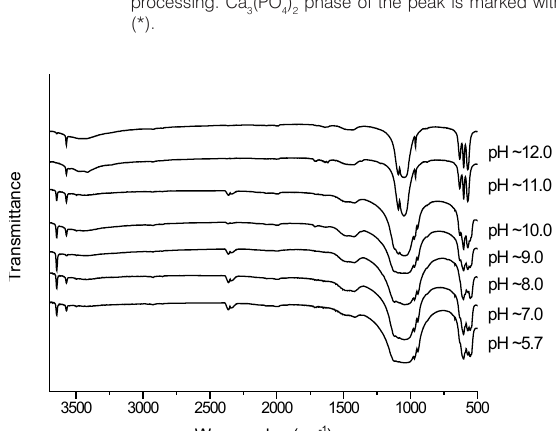
Figure 4. X-ray diffraction patterns of the HA samples synthesized at 1000 o C using different pH environment in the sol-gel processing. Ca (PO ) phase of the peak is marked with 3 4 2 (*).